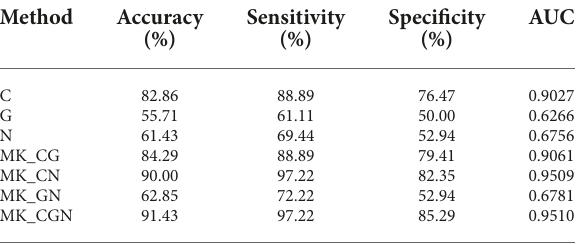
TABLE 5 Classification performance of different structural graph metrics.